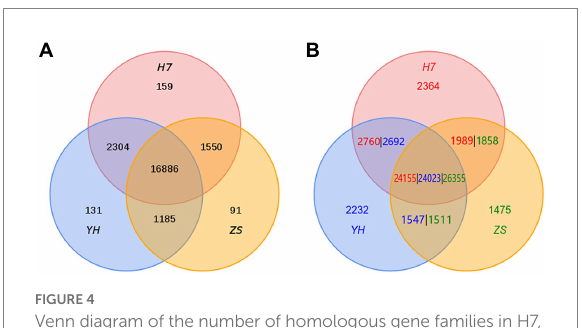
FIGURE 4 Venn diagram of the number of homologous gene families in H7, YH, and ZS genomes (A) and the number of homologous genes in H7, YH, and ZS genomes (B) , results from PAV analysis.